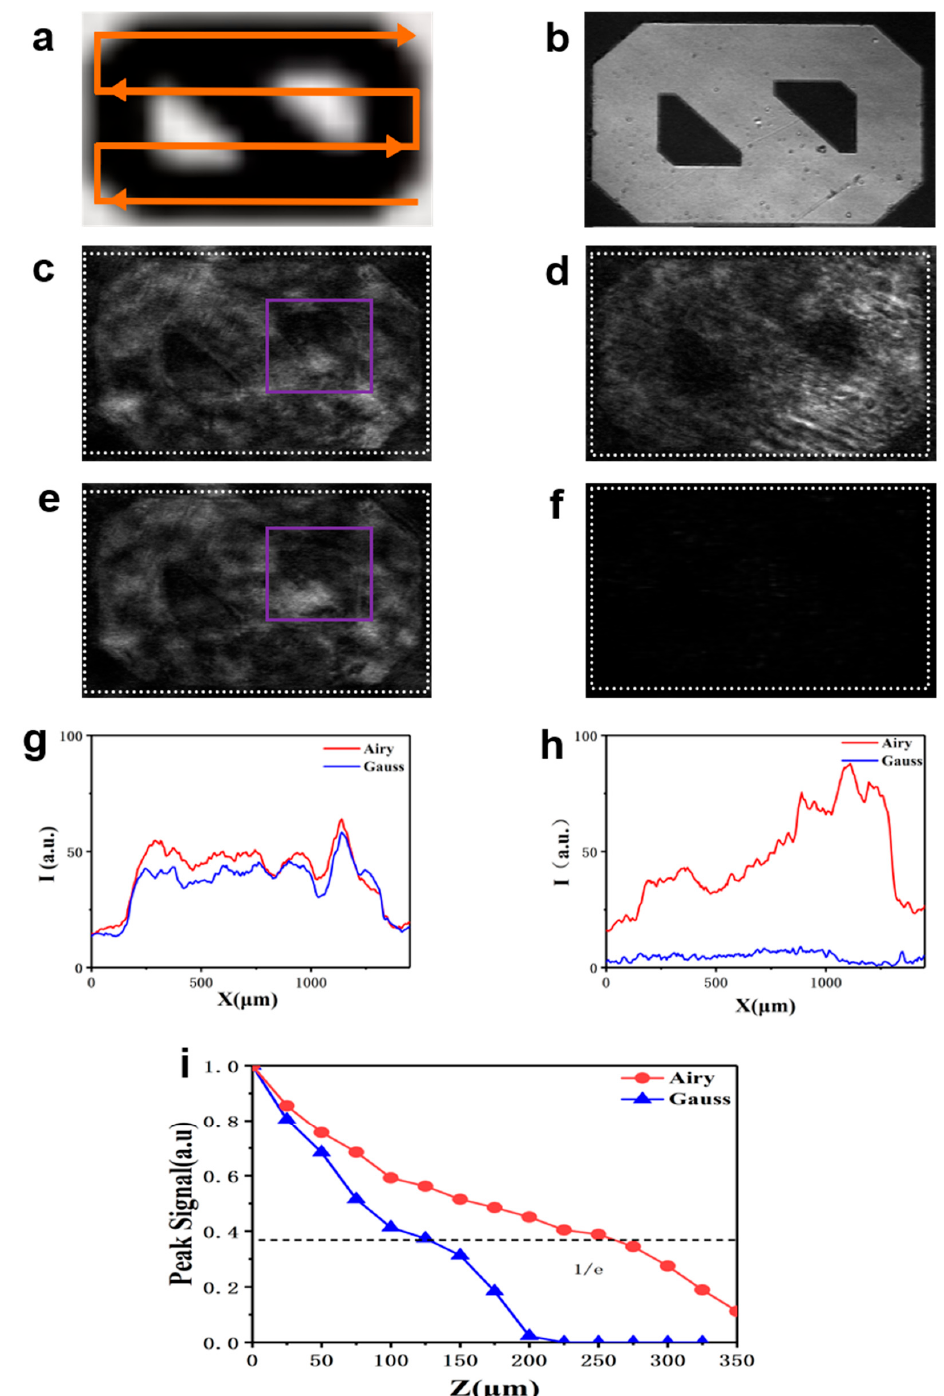
Figure 3. Relative intensity of the reflected light images from the target by line scanning with laser (633 nm) Airy and Gaussian beam. ( a ) Scanning method; ( b ) Image of the reflected light from the sample with no media; ( c ), ( e ) Images obtained with the Airy and Gaussian beams through a 150 µ m thick water/milk mixture, respectively; ( d ), ( f ) Images obtained with the Airy and Gaussian beams through 300 µ m thick water/milk mixture, respectively; ( g ) and ( h ) show the relative intensities of the reflected beam from ( c ) and ( e ) as well as ( d ) and ( f ) (the intensities projection along the long side in white dotted box), respectively: red is Airy and blue is Gauss; ( i ) Peak signals of reflected light at different thickness water/milk mixture for the Airy beam (red circles) and the Gaussian beam (blue triangles) microscopic imaging. Both signal intensities of the Airy beam and Gaussian beam are